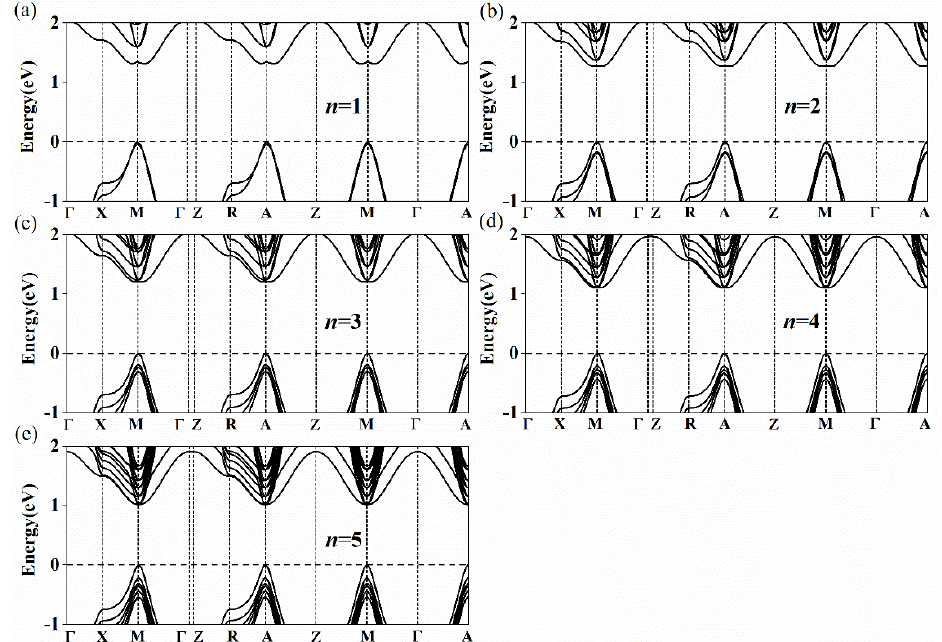
Figure 4. Calculated band structures of Cs n Sn n +1 Br 3 n +2 for ( a ) 1 layer, ( b ) 2 layers, ( c ) 3 layers, ( d ) 4 layers and ( e ) 5 layers. The high symmetry path is assumed with respect to the Brillouin zone center Γ with the coordinates (0, 0, 0) to X (0, 0.5, 0), M (0.5, 0.5, 0), Γ (0, 0, 0), Z (0, 0, 0.5), R (0, 0.5, 0.5), A (0.5, 0.5, 0.5), Z (0, 0, 0.5), M (0.5, 0.5, 0), Γ (0, 0, 0) and A (0.5, 0.5, 0.5).